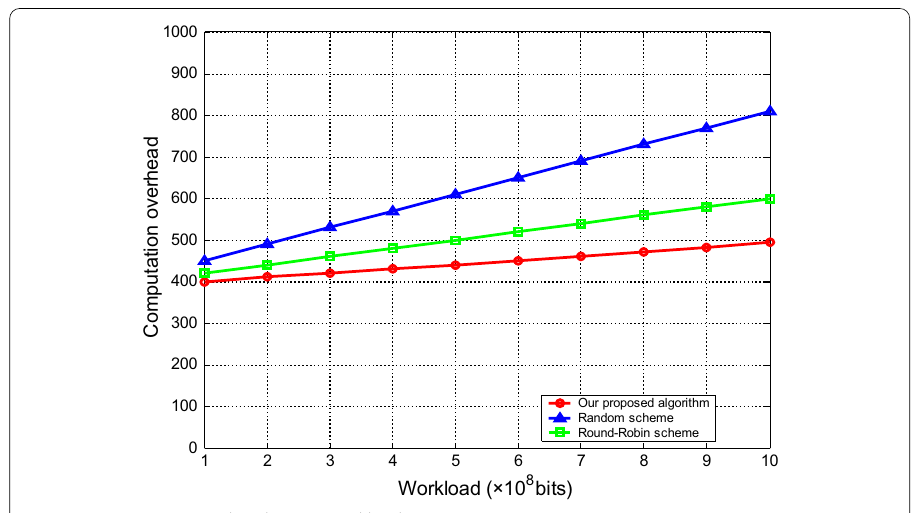
Fig. 5 Computation overhead versus